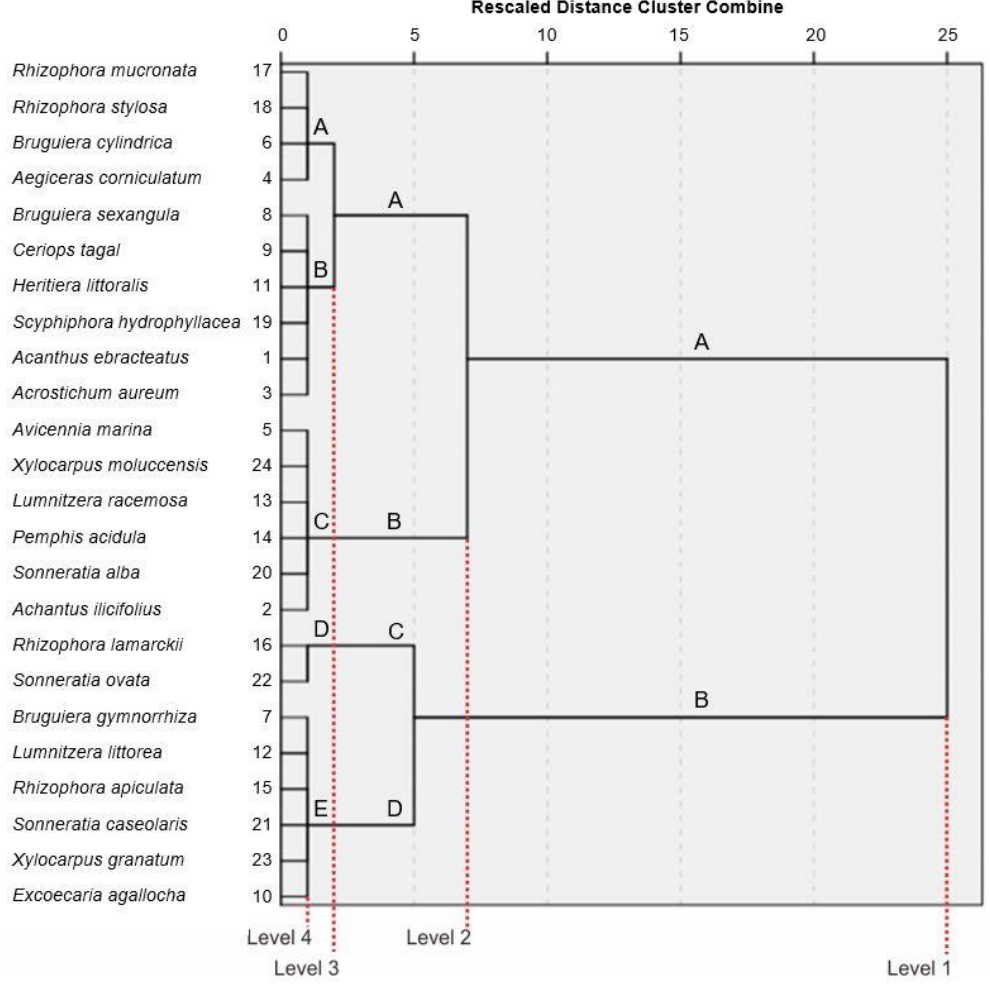
Figure 5. Dendrogram of mangrove species obtained with the Ward linkage method showing four levels of species grouping. Table 3. Mangrove species grouping of Levels 1 – 4 resulting from the cluster analysis.